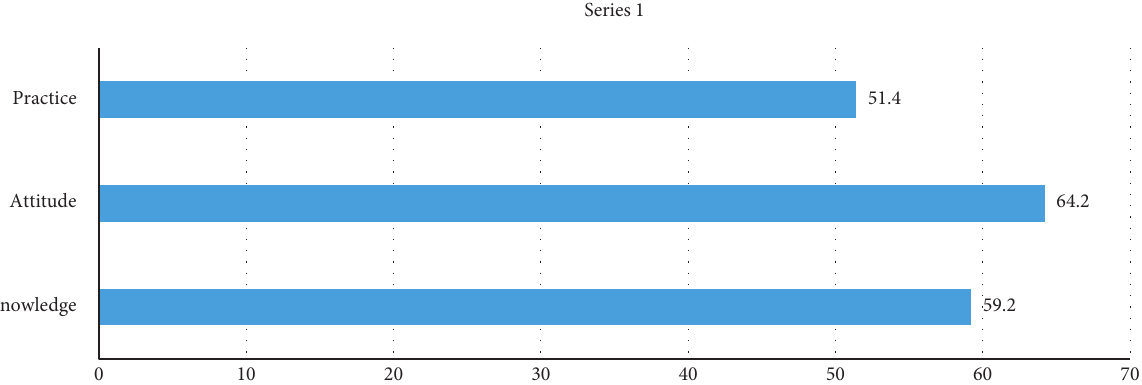
Figure 1: Comparison of nurses’ knowledge, attitude and practice in toothbrush maintenance and use. Table 2: Nurses’ knowledge, attitude, and practice scores in toothbrush maintenance and use.